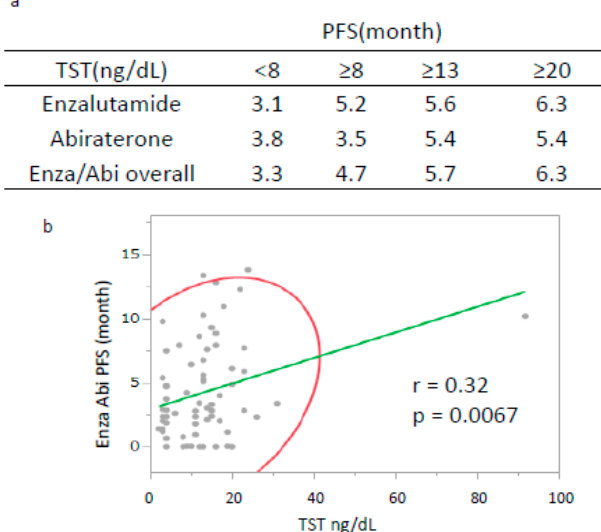
Figure 2. Progression-free survival based on the serum TST cut off level. ( a ) Progression-free survival according to TST level <8 ng/dL, ≥ 8 ng/dL, ≥ 13 ng/dL, or ≥ 20 ng/dL as the cut-off values in enzalutamide- and abiraterone-treated patients. ( b ) Correlation of serum TST level and progression-free survival in enzalutamide- and abiraterone-treated patients. The red circle indicates 95% of data used for the correlation analysis, to avoid errors. Table 3. Comparison of clinical factors in patients with TST < 13 ng/dL and TST ≥ 13 ng/dL. TST < 13 TST ≥ 13 P -Value Median (Average) Median